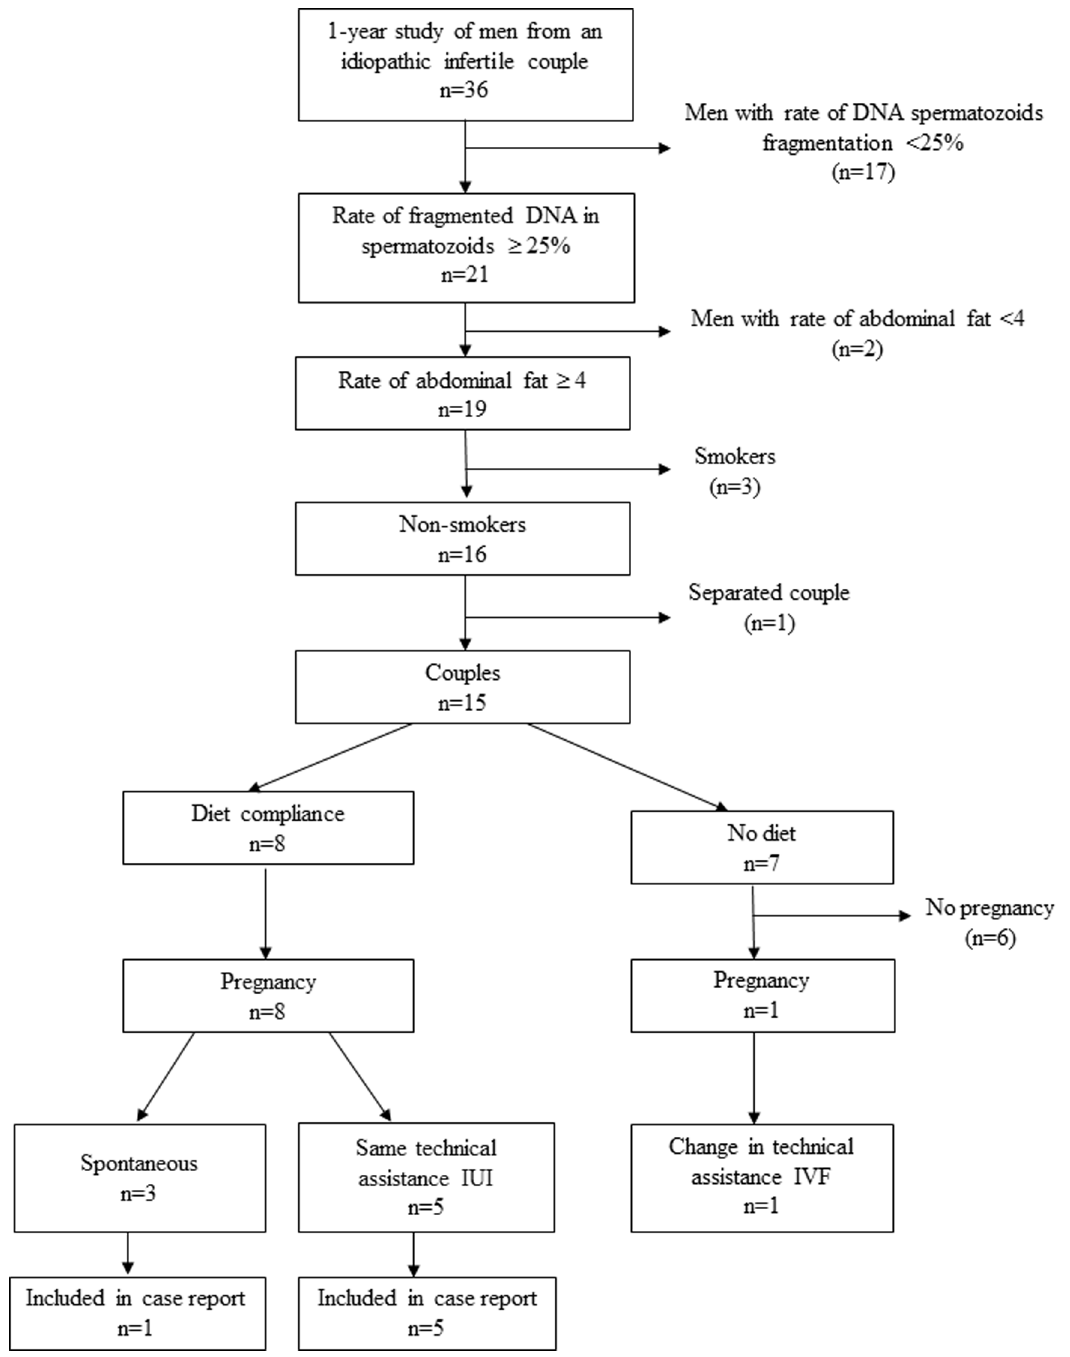
Figure 1. Design of the study.